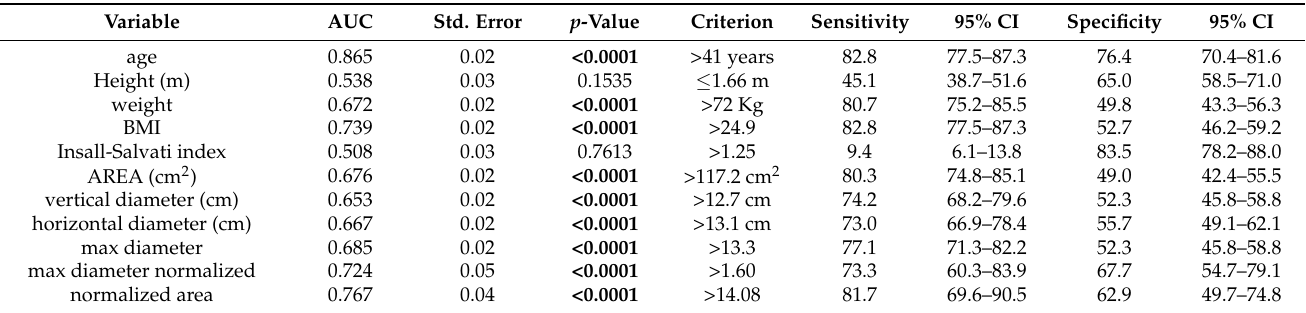
Table 5. Accuracy (AUC) of demographic and radiologic parameters for the prediction of severe knee degeneration (Outerbridge > 2).